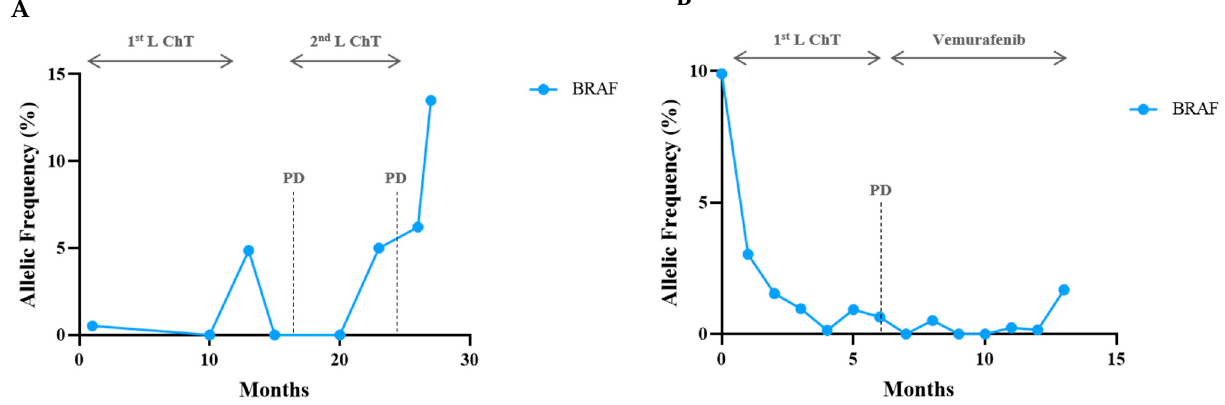
Figure 8. CtDNA monitoring in BRAF 600E mutant patients. In ( A ), 1st line chemotherapy (Cht) with maintenance was stopped due to optic neuropathy. In the treatment-free interval, there was an increase in ctDNA, followed by ctDNA clearance after 2nd line treatment, which was performed until local progression and brain metastasis (24th month). Increase in the BRAF allelic frequency preceded PD in one month. In ( B ), the patient progressed on 1st line chemotherapy with leptomeningeal metastasis at month 4, not accompanied by VAF increase. With vemurafenib, there was a neurological and thoracic improvement with BRAF V600E ctDNA clearance. The patient developed a large pleural effusion and clinical deterioration escorted by ctDNA increase and death.